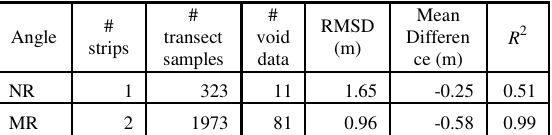
Table 6. Comparison of h spc for 2,296 sample points located along transect lines of slopes <10 ° across NR and MR incidence angles (FR data were not available) for the International Falls site, generated from single-pass X-HH InSAR compared to NEXTMap X-HH InSAR (multi-pass). Table 7. Comparison of h spc for 11.608 sample points located along transect lines of slopes <10 ° across all three incidence angles for the Arizona site, generated from single-pass X-HH InSAR compared to NEXTMap X-HH InSAR (multi-pass).